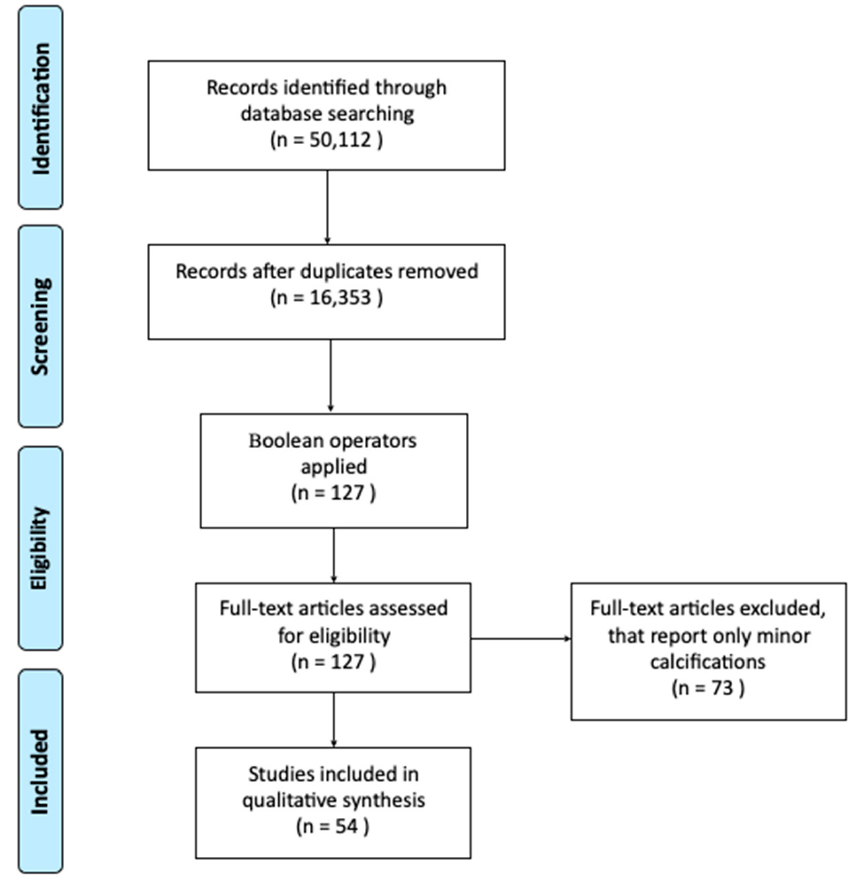
Figure 1. Flowchart for identification of relevant research, screening and selection. Based on PRISMA guidelines and the scoping review framework described by Arksey and O’Malley [16].